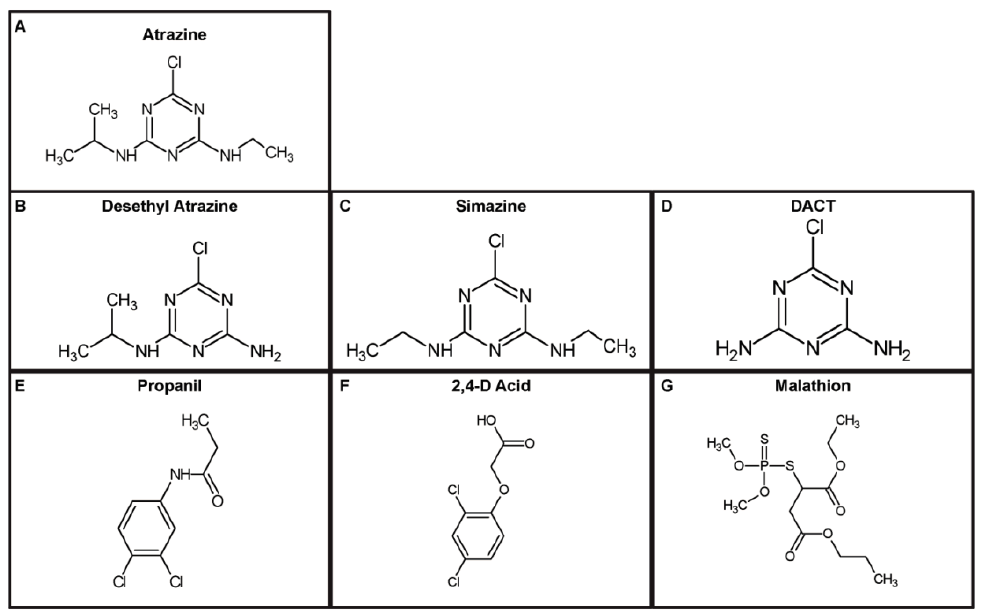
Figure 2. Chemical structures of molecules used in the SELEX scheme and cross-binding assays. ( A ) Structure of the herbicide and target of selection atrazine; ( B ) Structure of atrazine derivative desethyl atrazine, used to immobilize onto magnetic beads; ( C , D ) Structures of simazine and diamino-chloro-triazine (DACT): chemically similar to atrazine, and used in rounds of negative selection; ( E – G ) Structures of propanil, 2,4-D acid, and malathion: pesticides found in ecologically relevant environments to atrazine and used in negative selections.